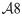
Illustration of bicluster found within gene-expression data-set.Both panels illustrate the same submatrix (i.e., bicluster) drawn from the full case-matrix shown at the top of Fig 4. This bicluster was found using our control-corrected biclustering algorithm (described in section A8 of S1 Text). In Panel-A we represent this bicluster using the row- and column-ordering given by the output of our algorithm. This ordering has certain advantages (see section A14 of S2 Text), but does not make the co-expression pattern particularly clear to the eye. Thus, to show this co-expression more clearly, we present the bicluster again in Panel-B, except this time with the rows and columns rearranged so that the coefficients of the first principal-component-vector change monotonically. As can be seen, there is a striking pattern of correlation across the 793 genes for the 45 cases shown.